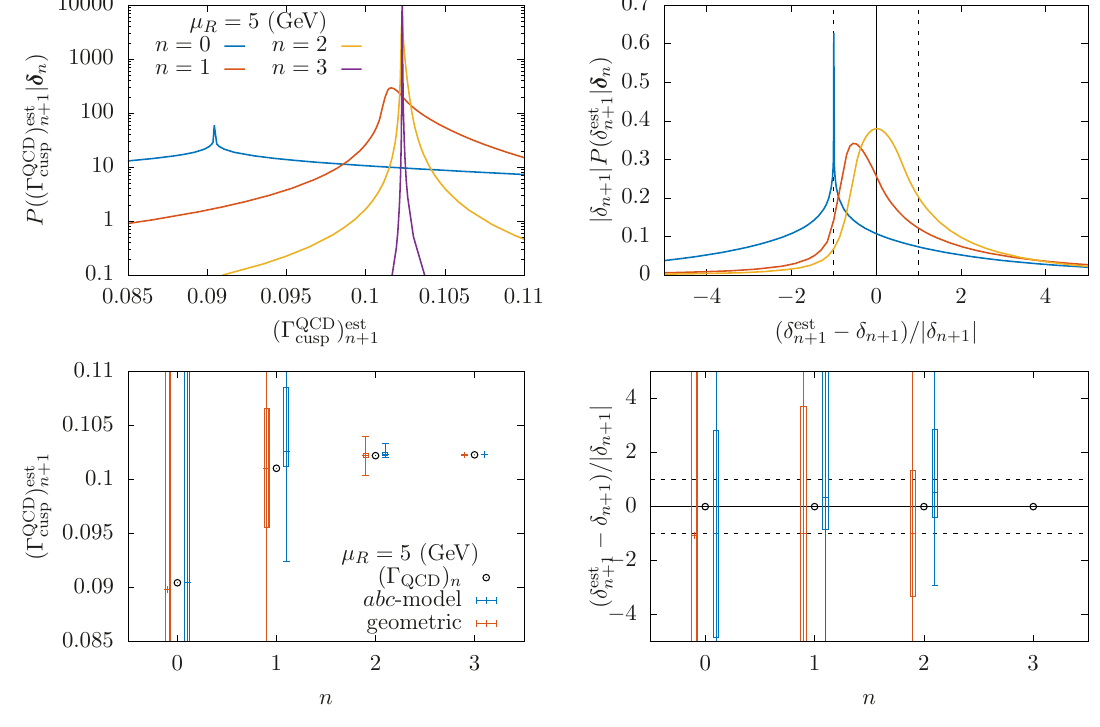
Figure 7 . Top left panel: the probability distribution from the abc -model for the QCD cusp anomalous dimension (Γ QCD ) est evaluated with α ( µ = 5 GeV ) ≈ 0 . 213 and for different values of s R cusp n +1 n . Top right panel: the same distributions normalized to the exact N n +1 LO correction. Bottom left panel: the median (plus), 68% CI (errorbox) and 95% CI (errorbar) for the posterior of (Γ QCD computed from the abc (blue) and geometric (red) models using information on the previous orders. The exact values of (Γ QCD ) are shown as black circles. Bottom right panel: CIs scaled to the exact n cusp N n +1 LO